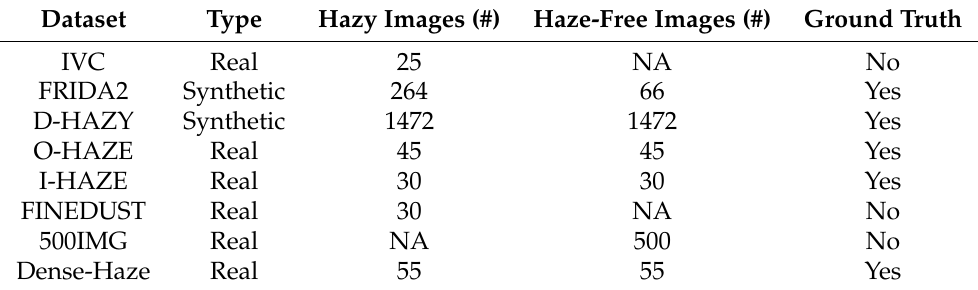
Table 1. Summary of the real and synthetic datasets employed in this study. NA stands for not avail-